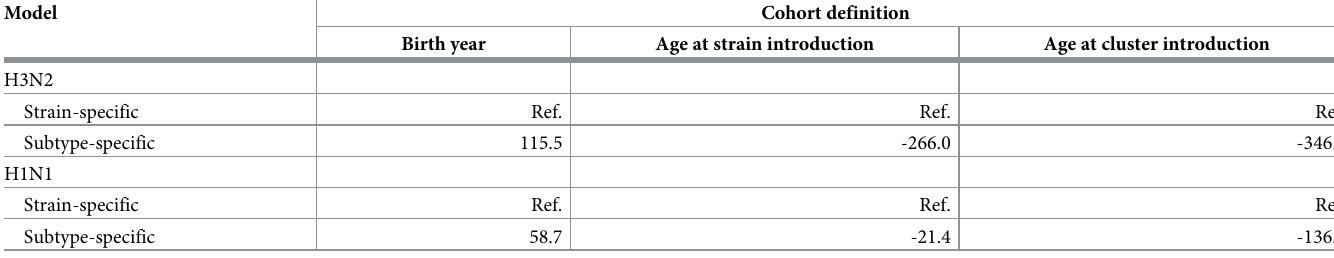
Table 2. Comparison of period–cohort models for the H3N2 and H1N1 strains.